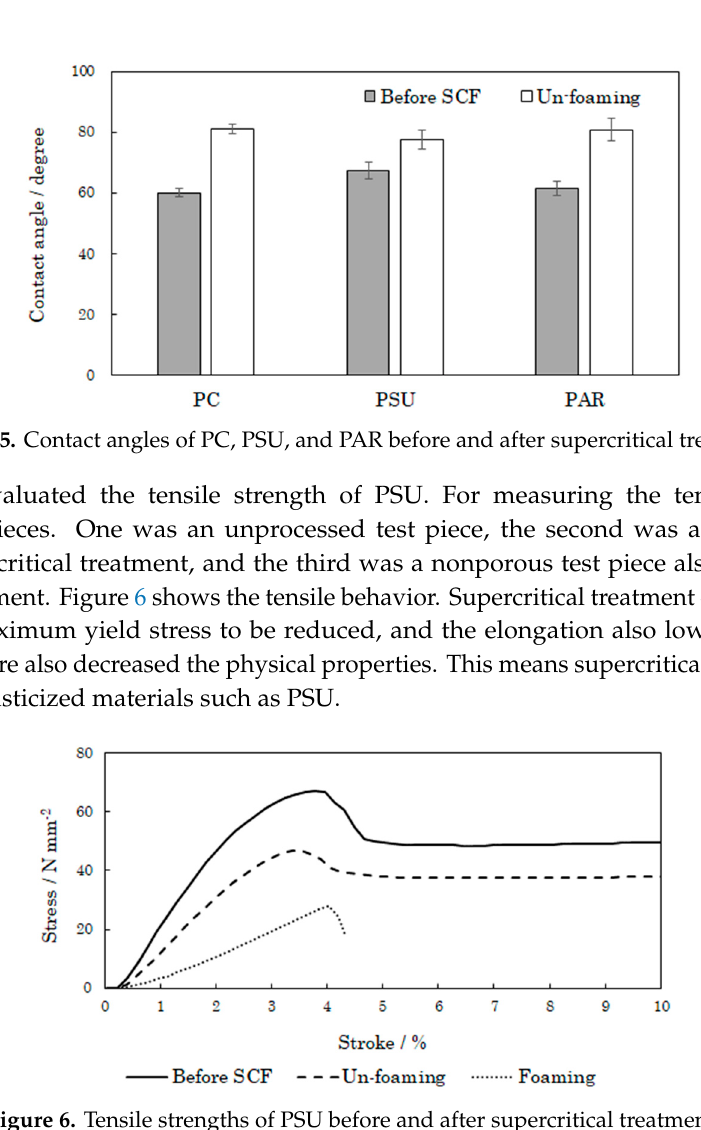
Figure 6. Tensile strengths of PSU before and after supercritical treatment.